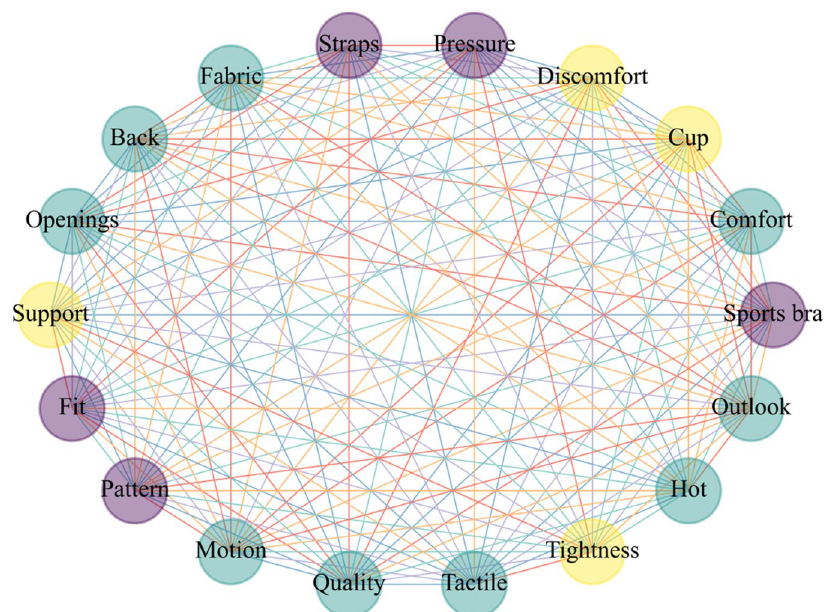
Fig. 3 Community detection for keywords. Keywords were clustered into two communities, one community was in purple color, the other one was in yellow color